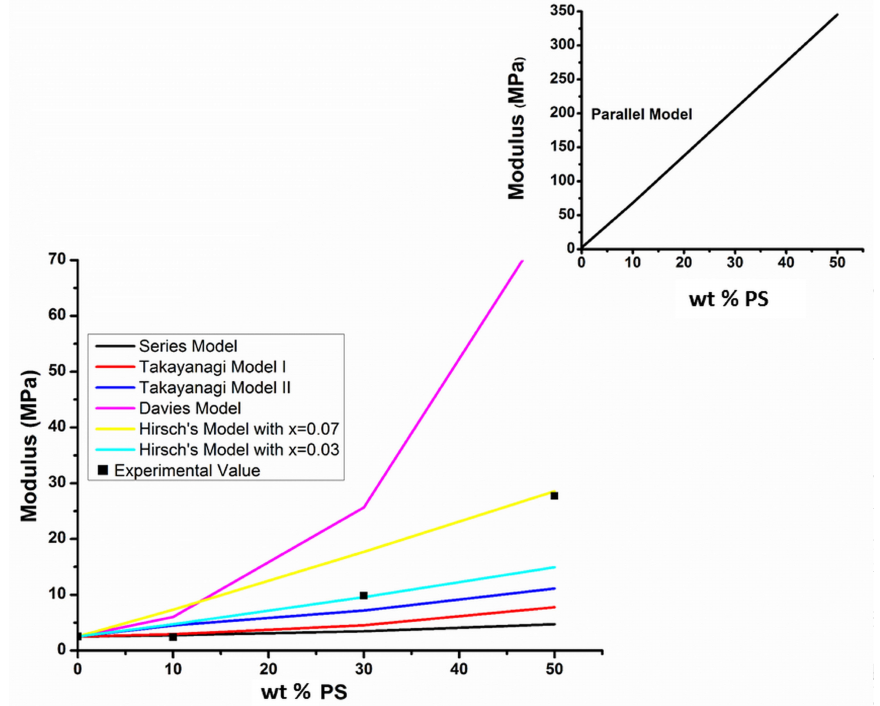
Figure 6. Comparison of the experimentally-determined tensile modulus values of the blends with the predictions of the